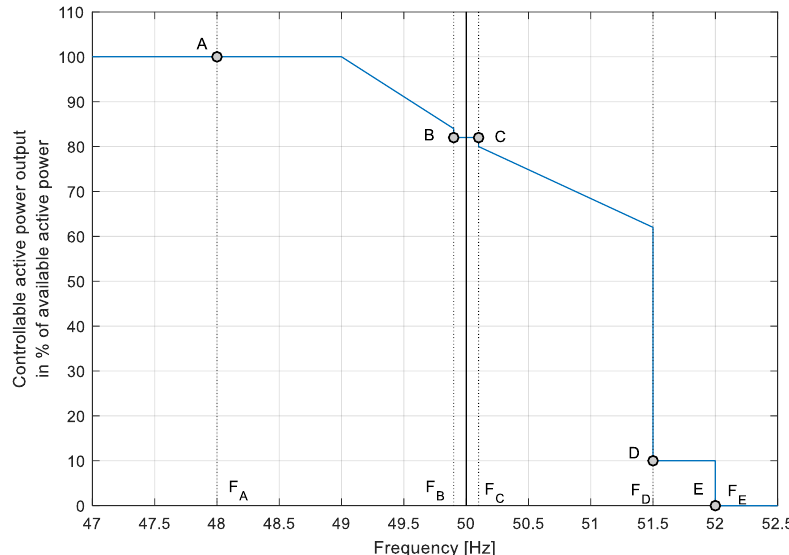
Figure 5. PFC requirements during frequency sensitive mode in the Irish grid code [2].